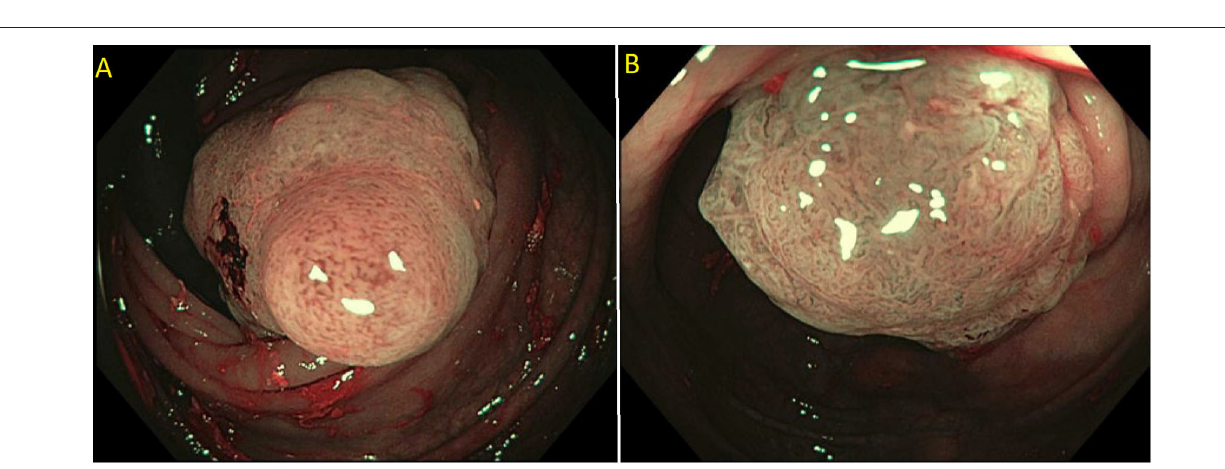
FIGURE 4 | (A) Paris 0-IIa lateral spreading lesion; (B) On NBI, lesion classified as a JNET 2B. Histology revealed tubular adenoma with high grade